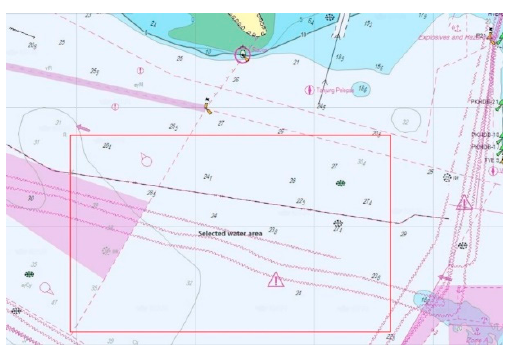
Figure 7. Selected water area-2 [44,45].